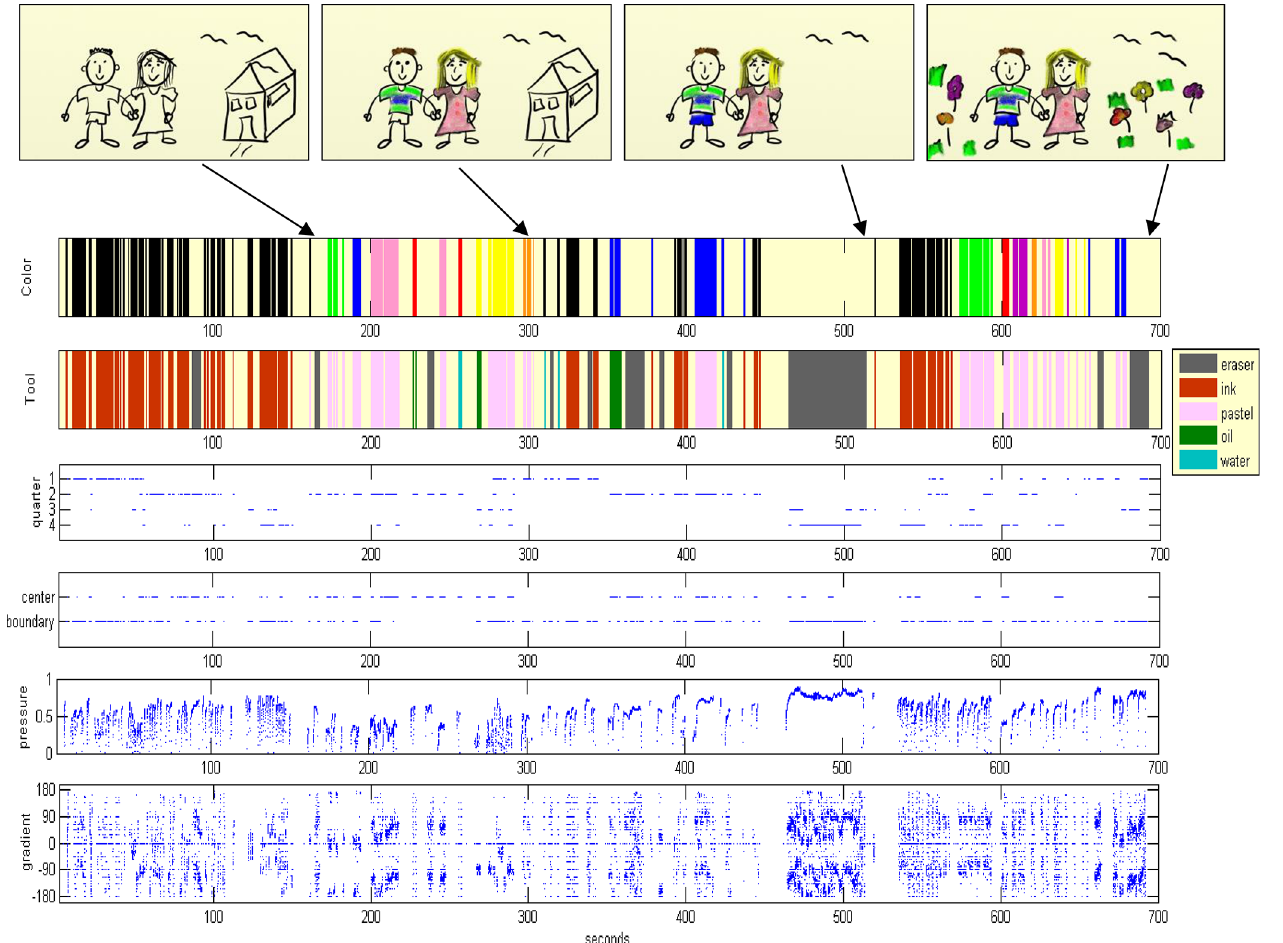
Fig 9. Visualization of an art making process (a positive feeling). A visual report of the creation process dynamics of an artwork imaging a positive